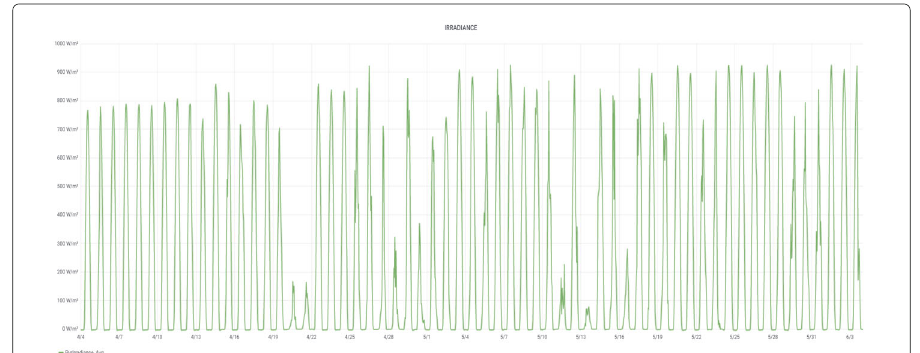
Fig. 3 GHI measured on the Kindergarten’s rooftop, in W / m 2